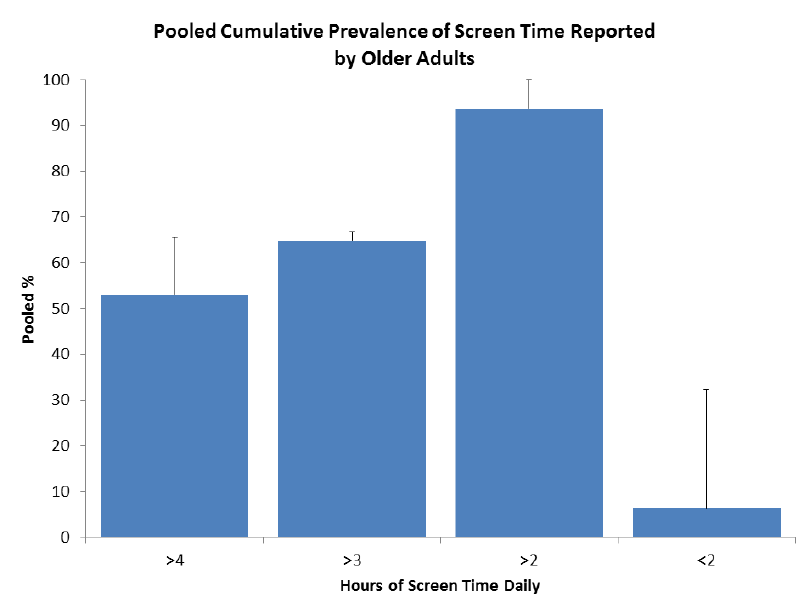
Figure 6. Meta-prevalence of screen time older adults, N = 105,424, n = 3, note <2 (6%) and >2 (94%) =